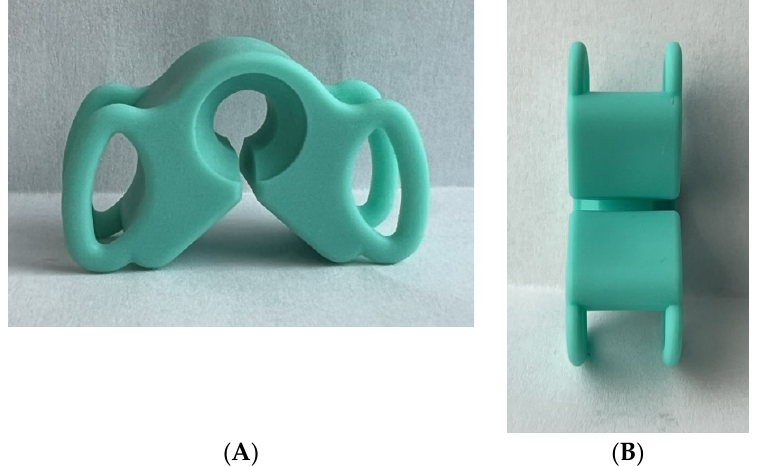
Figure 2. Teethers (Morde block teethers size S (Bader laboratory, reference 11/022)) used in the ICTest. ( A ) Lateral view; ( B ) anterior view.